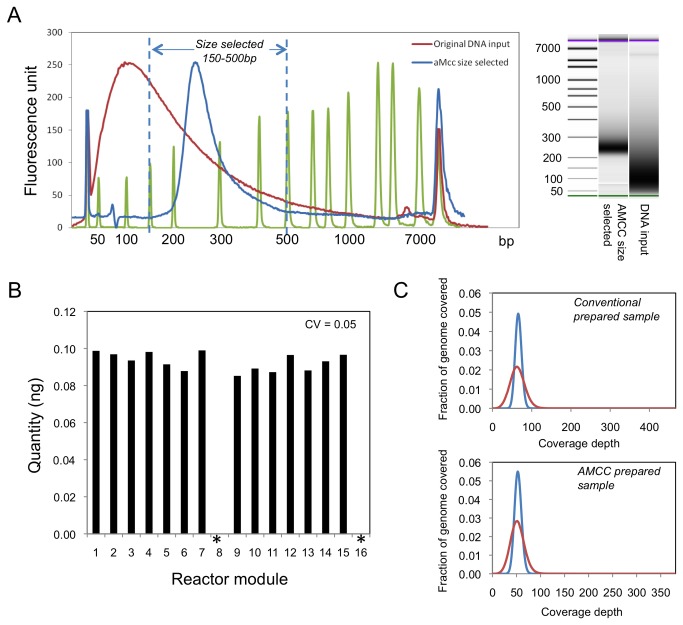
Combining NGS library preparation with size selection on the AMCC chip.Columns were formed on the AMCC chip using carboxylated beads. (A) Electropherogram showing size selection on-chip, illustrating the recovery of DNA fragments in the range of 150-500 bp. The green trace represents the DNA ladder used. GEL image extracted from a high sensitivity chip run on the Bioanalyzer 2100. (B) Quantification of Illumina library DNA eluted from the AMCC chip using RT-qPCR. Coefficient of variation (CV) for this chip run was 0.05. Asterisks indicate sample modules where buffer was loaded instead of genomic DNA. (C) Coverage depths from sequencing runs of libraries prepared on the AMCC chip and using the conventional benchtop protocol recommended by the manufacturer.